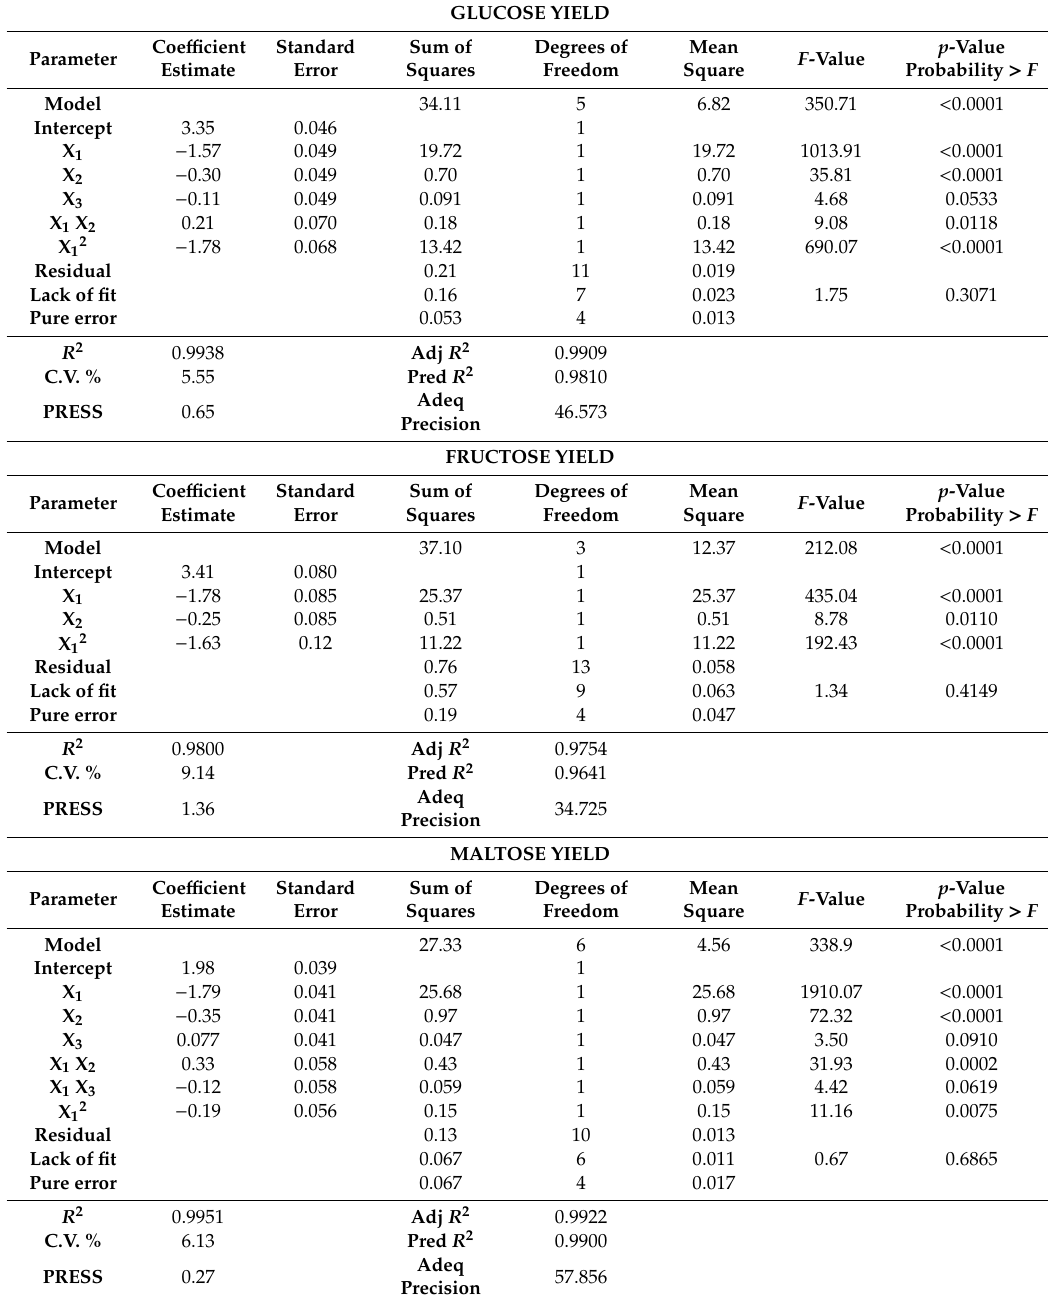
Table 9. The values of regression coe ffi cients and analysis of the models for yield of